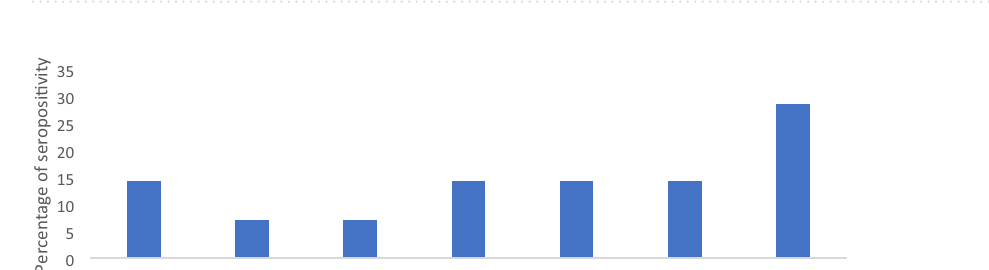
Figure 1. Age specific prevalence by gender of respondents.